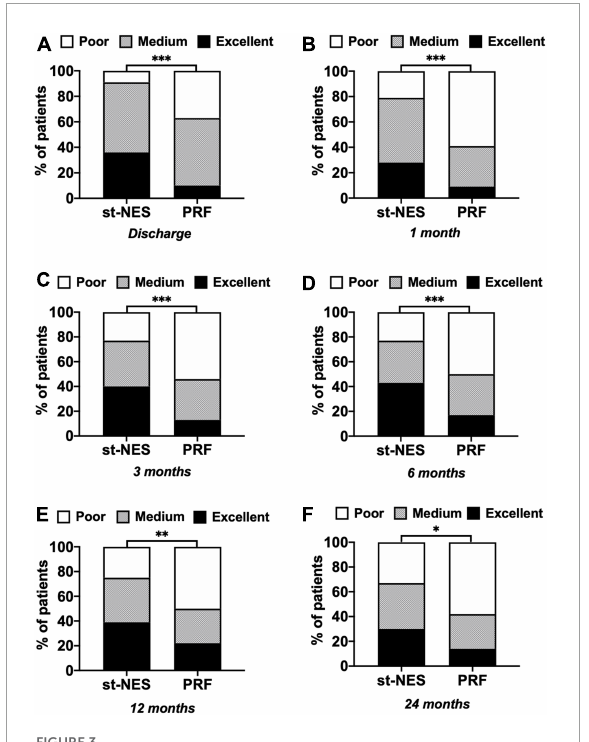
FIGURE3 (A–F) The proportion of people with excellent, medium, and poor outcomes of numerical rating scale (NRS) reduction rate in short-term nerve electrical stimulation (st-NES) and pulsed radiofrequency (PRF) group at discharge, 1, 3, 6, 12, and 24 months follow-up ( n = 226, * P < 0.05, ** P < 0.01, *** P < 0.00, indicate PRF group vs. st-NES group, P -values for group comparison by chi-square test).